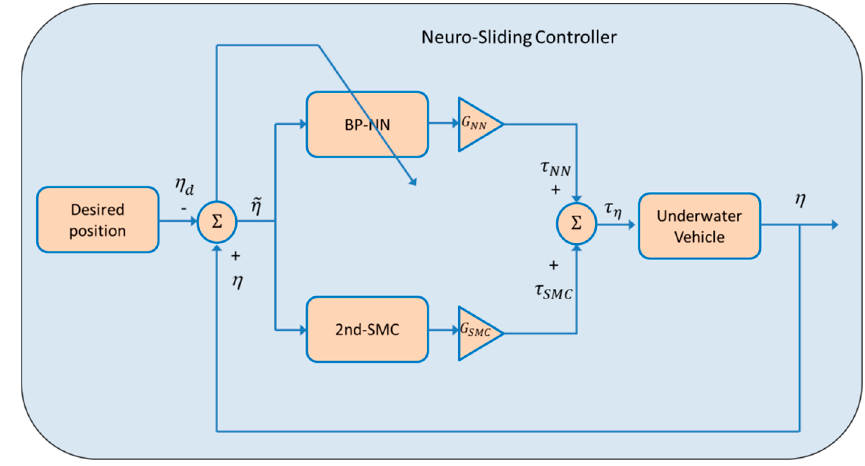
Figure 2. Block diagram of the neuro-sliding controller (NSC).